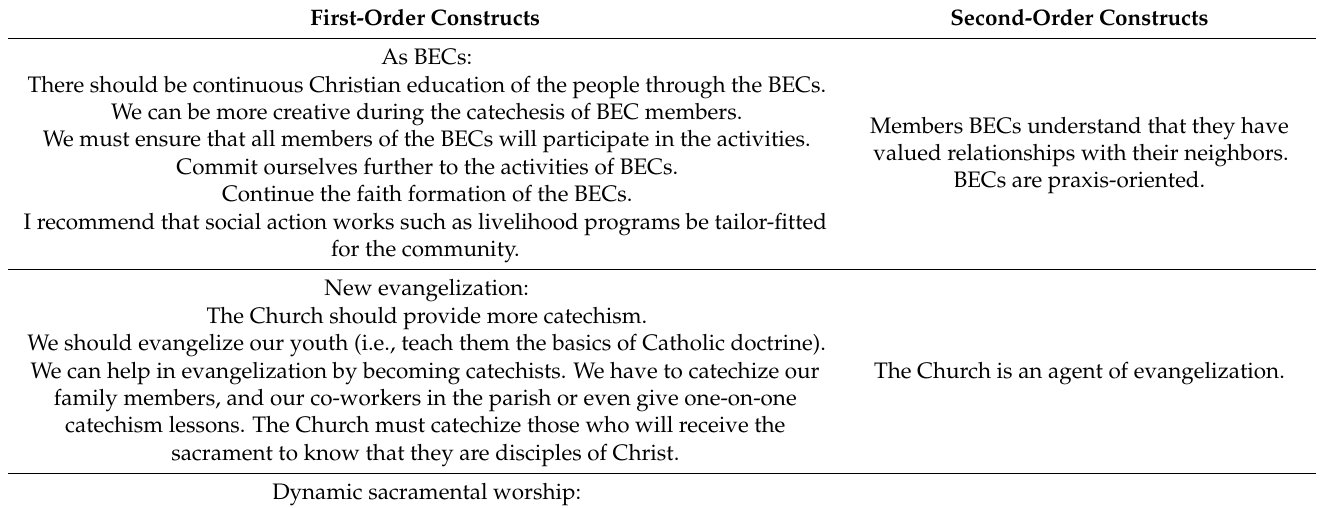
Table 3. In these modern times, how can the Church fulfill its